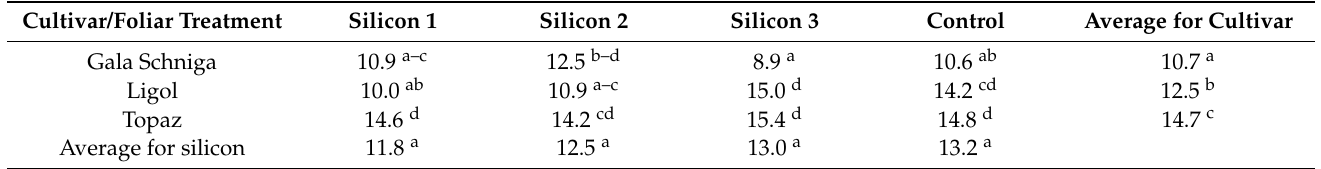
Table 3. TCSA of apple trees depend on cultivar and foliar silicon treatment (cm 2 ).